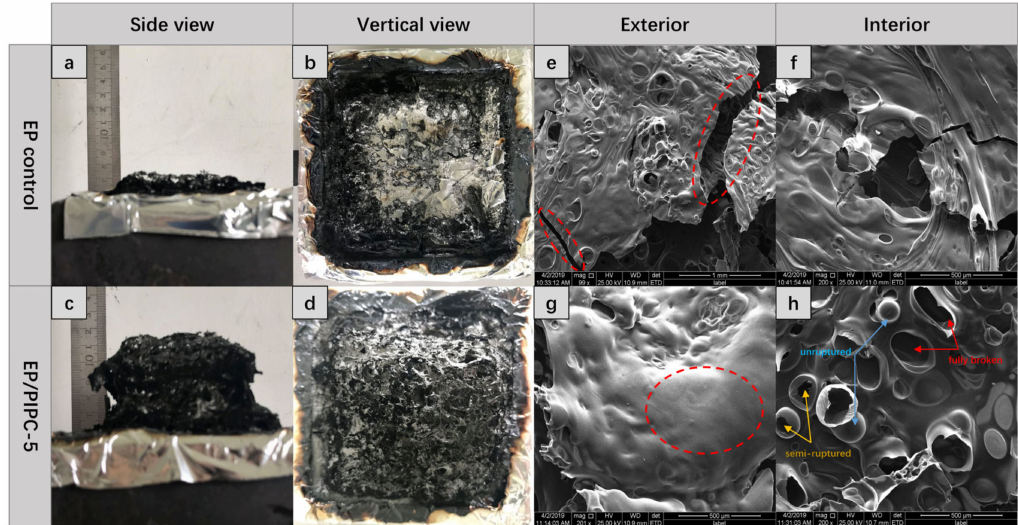
Figure 7. Digital photos ( a – d ) and SEM images ( e – h ) of the char residues from EP control and EP / PIPC-5,